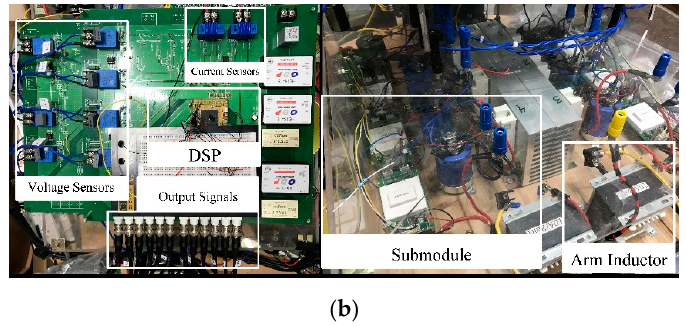
Figure 11. Experimental setup of the single-phase seven-level MMC: ( a ) a circuit diagram; ( b ) single- phase seven-level prototype and control board. ( b ) single-phase seven-level prototype and control board.